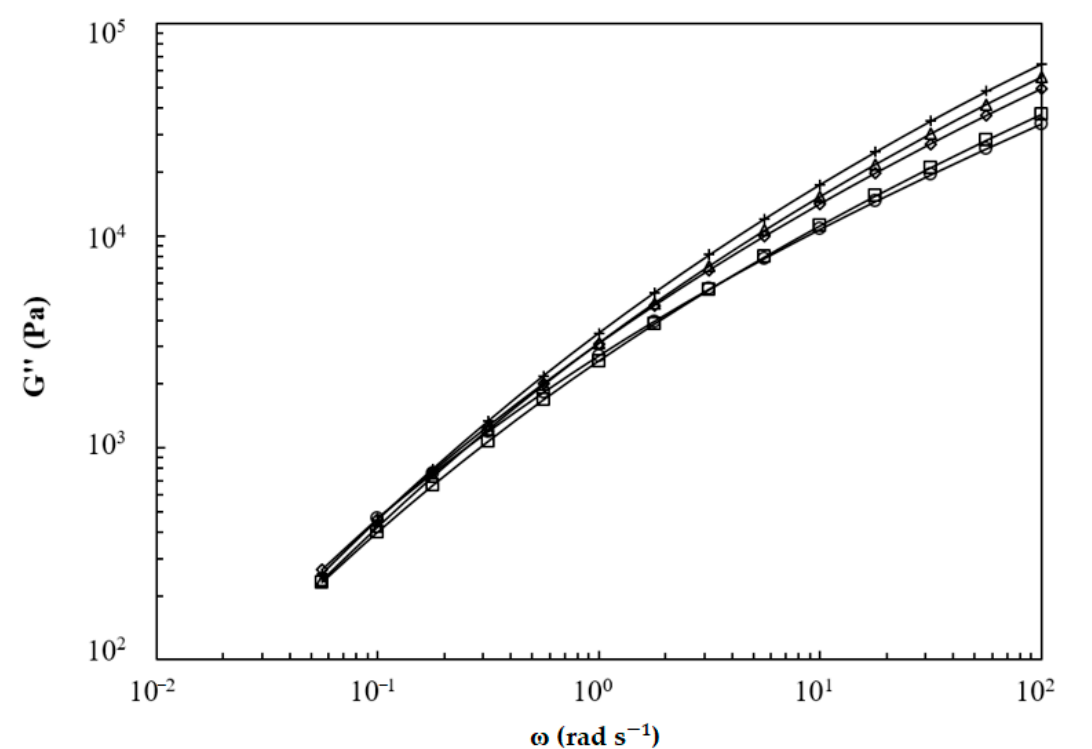
Figure 5. Storage modulus of BPBS (•), LPBS (+), and BPBS/LPBS blends ( ■ ) 80/20%, ( ◆ ) 50/50%, ( ▲ ) 20/80% at 150 °C.